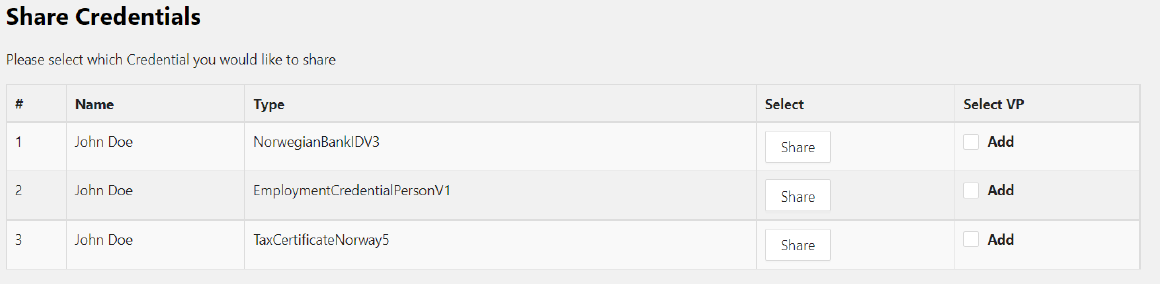
Figure 8. Holder’s wallet showing required